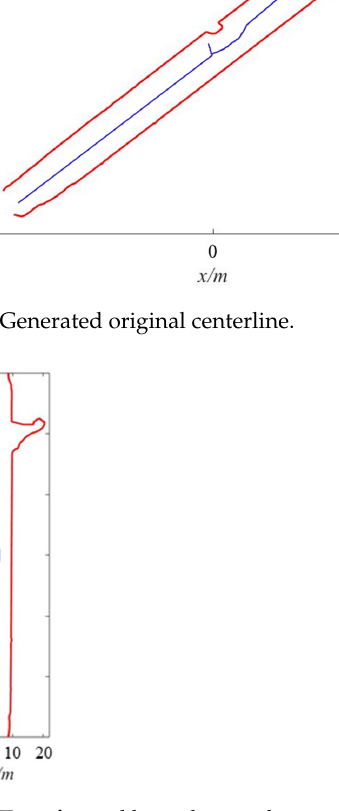
Figure 11. Transformed boundary and centerline of the main road.